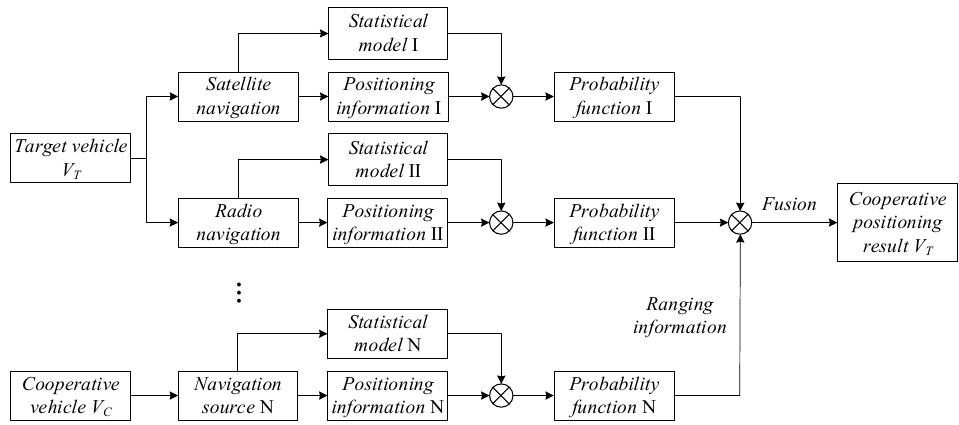
Figure 2. Fusion architecture based on information geometric probability.